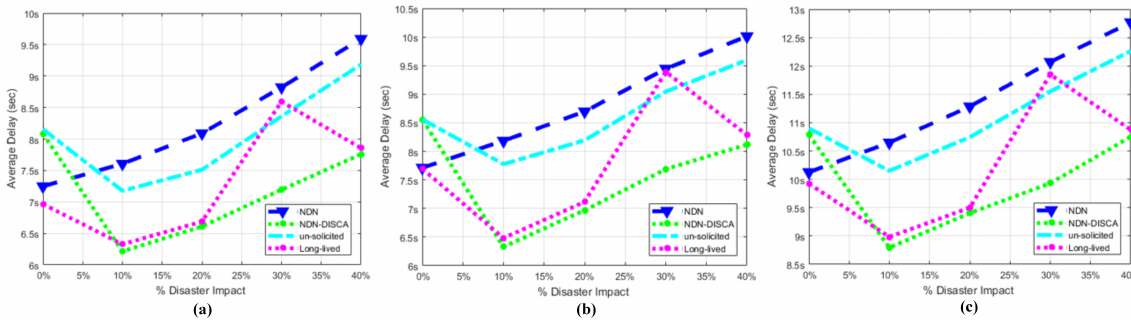
Figure 8. Overall Message (Transmission + Propagation) Delay of SC when Fire Disaster is Being Held in SL-2 w.r.t Three Partition Chunks ( a ) SL-1, ( b ) SCL, ( c )